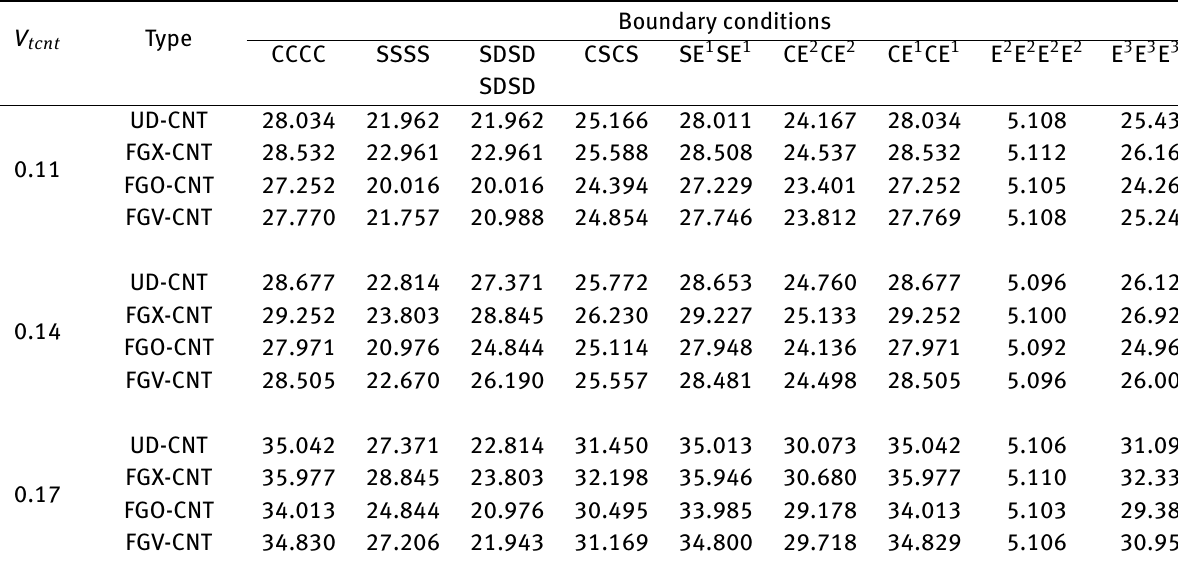
Table 5: Fundamental frequency parameters Ω for FG-CNT reinforced composite annular sector plates with different boundary conditions